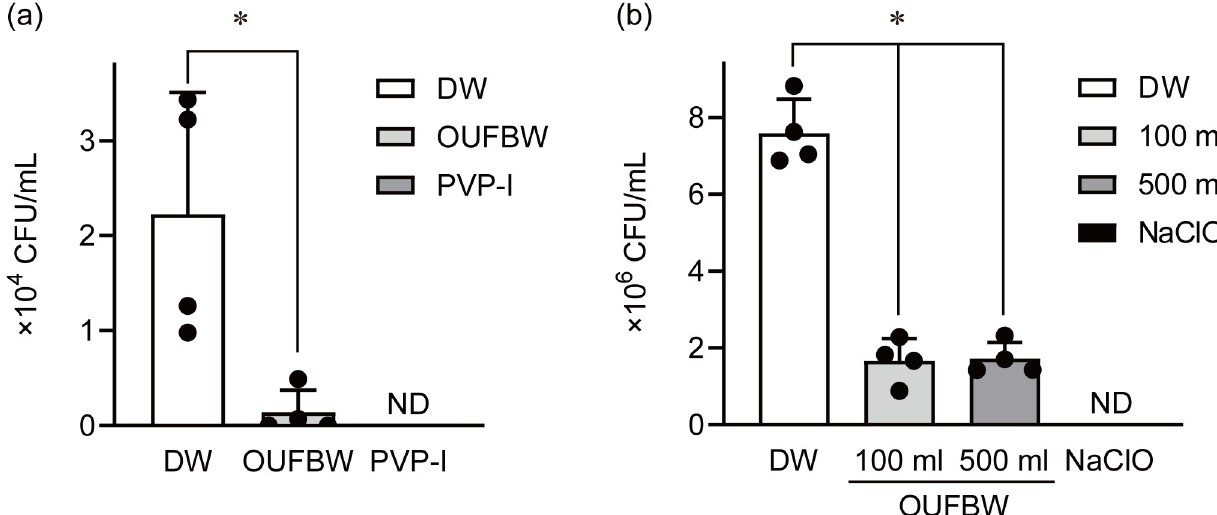
Fig 4. Bactericidal activity of ozone ultrafine bubble water (OUFBW) against contaminated toothbrushes and gauzes. (a) The toothbrushes contaminated with S . pneumoniae and (b) The gauzes contaminated with P . aeruginosa were immersed in distilled water, OUFBW (approximately 5 ppm of ozone concentration), 0.1% povidone iodine or 0.1% NaClO for 5 min. (a, b) Toothbrushes and gauzes were transferred into fresh distilled water (toothbrush: 7 mL, gauze: 5 mL), and then the bacteria attached them were harvested by ultrasonication (43 kHz, 5 min). Bacterial load of S . pneumoniae and P . aeruginosa were determined by colony count. Data represent the mean ± SD of quadruplicate determinants, and were evaluated using Dunnett’s multiple-comparisons test. * P < 0.05 versus the control group. ND stands for undetected and indicates below the detection limit (a: < 70 CFU/mL, b: < 5 × 10 3